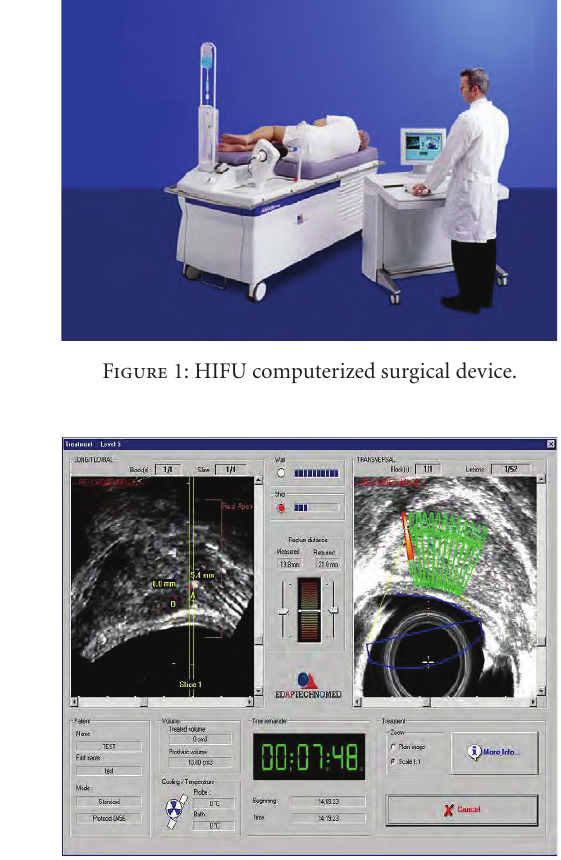
Figure 2: Monitor for setting and controlling the treatment proce-